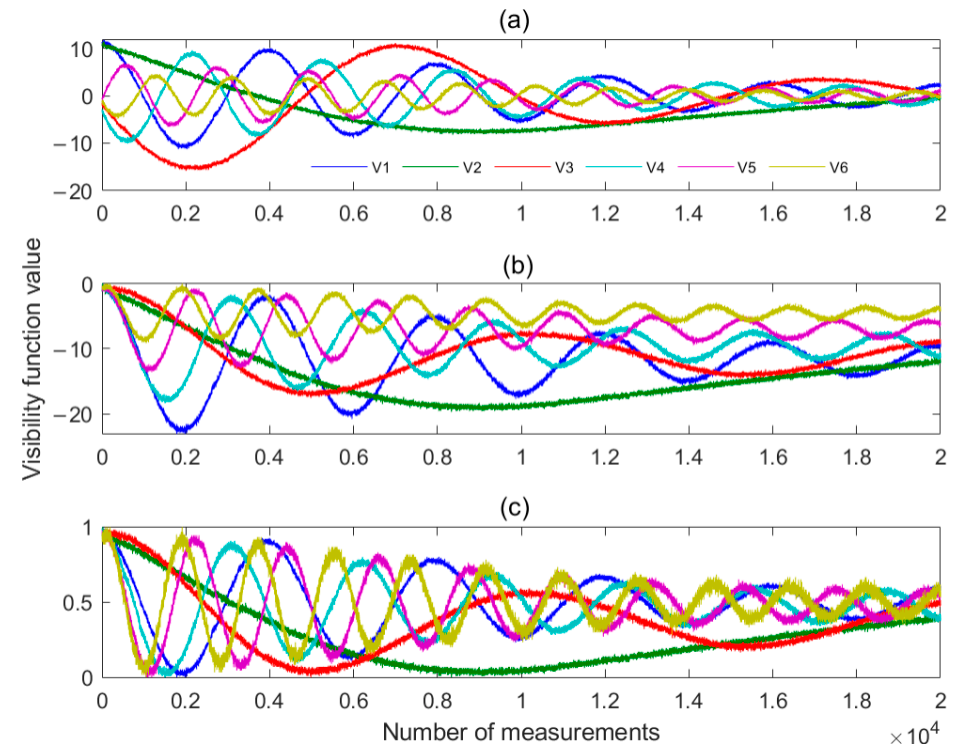
Figure 9. Visibility function calibration process. ( a ) is the raw visibility function, ( b ) is the visibility function after calibration for phase error, and ( c ) is the visibility function after calibration for mag- nitude error.